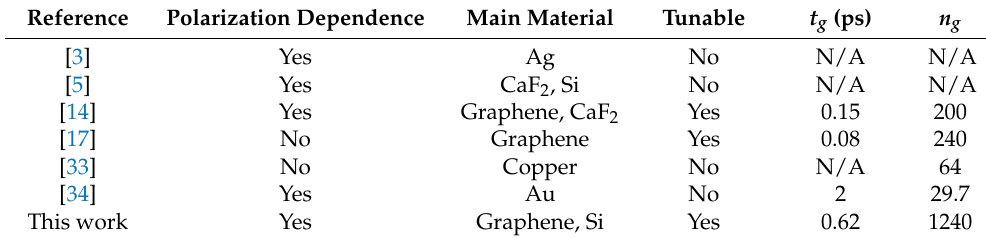
Table 1. Comparison of the proposed structure and the latest relevant designs.